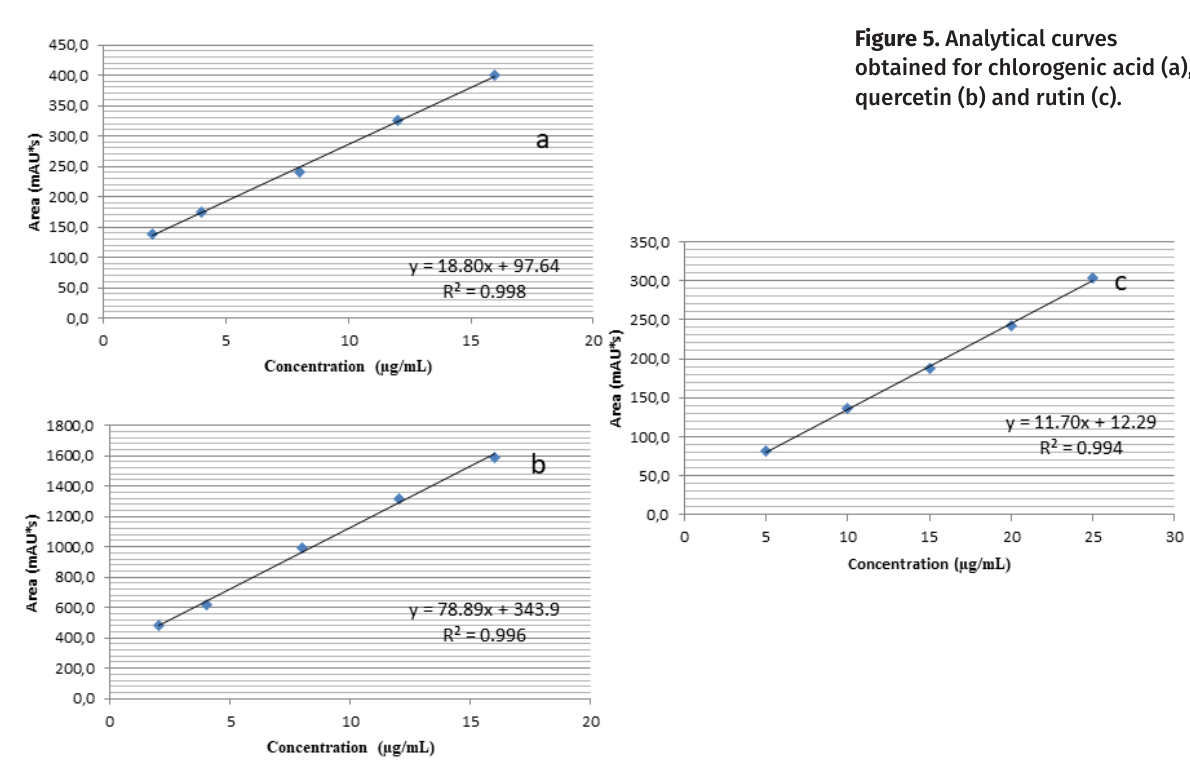
Figure 5. Analytical curves obtained for chlorogenic acid (a), quercetin (b) and rutin